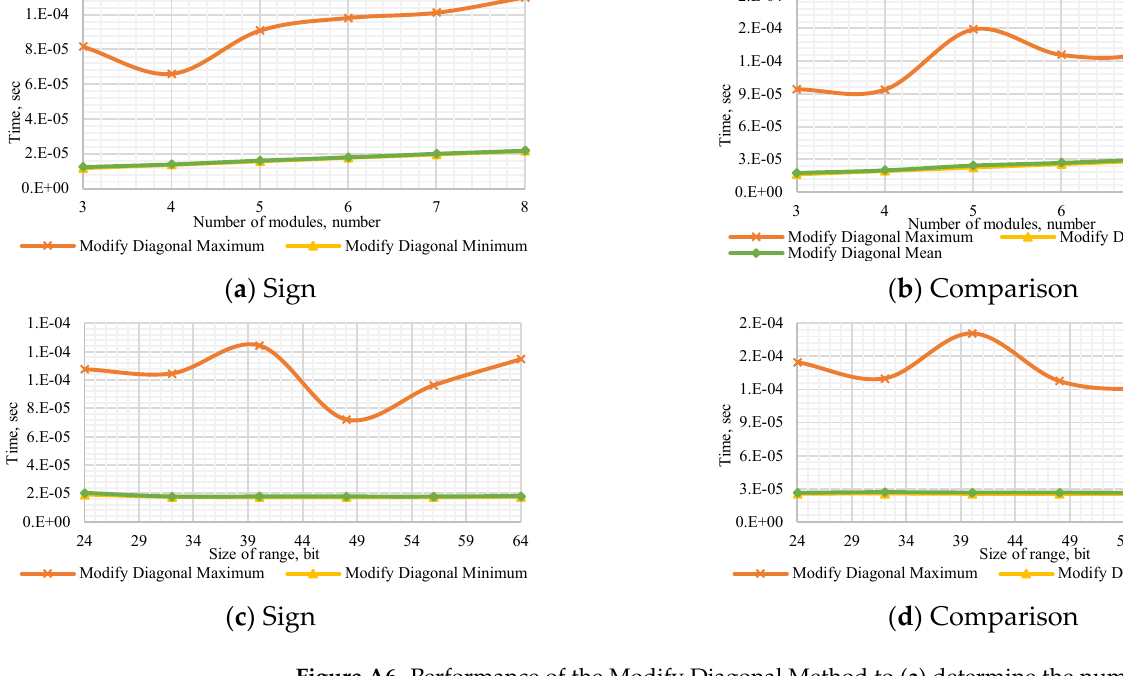
Figure A6. Performance of the Modify Diagonal Method to ( a ) determine the number’s sign with a dynamic number of modules p , ( b ) compare dynamic numbers of modules p , ( c ) determine the number’s sign with a dynamic bit width, and ( d ) compare numbers with dynamic bit width.